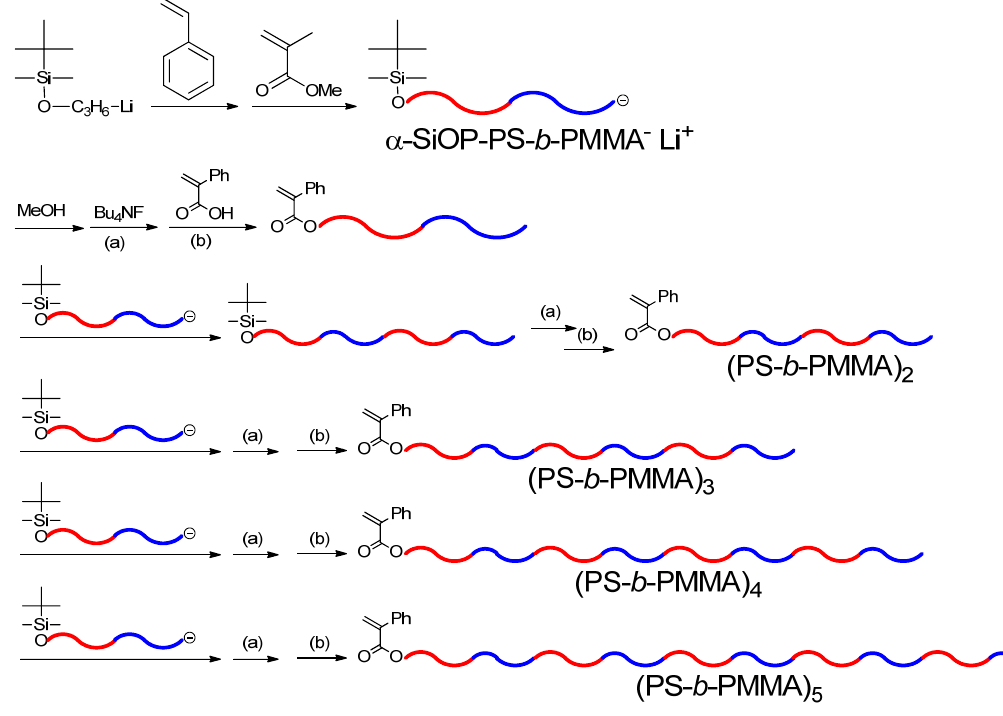
Figure 1. SEC profiles for a series of multiblock copolymers: ( a ) AB diblock; ( b ) (AB) hexablock; ( d ) (AB) tetrablock; ( c ) (AB) 3